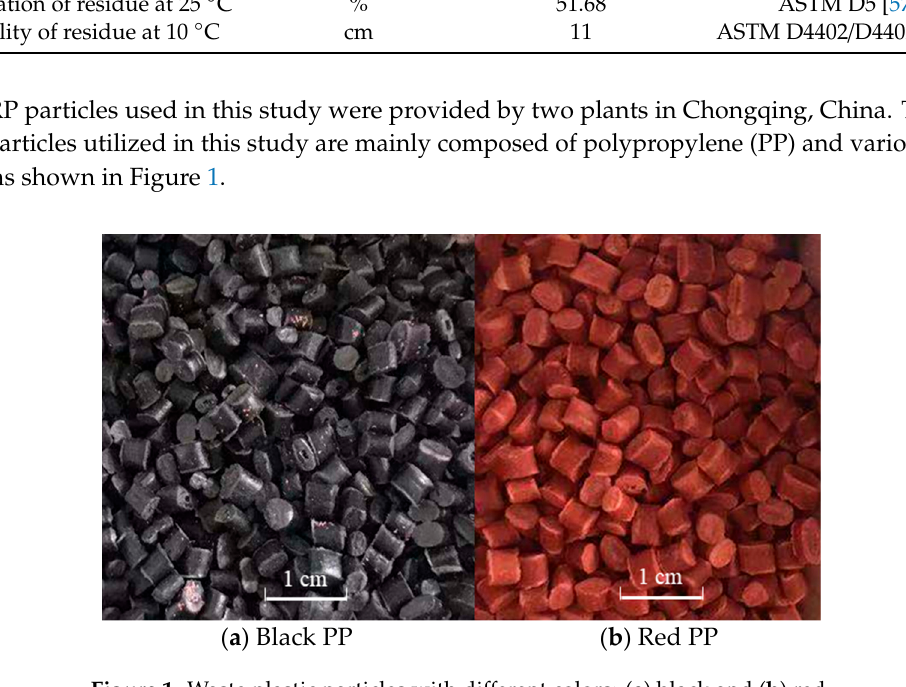
Figure 1. Waste plastic particles with different colors: ( a ) black and ( b ) red .